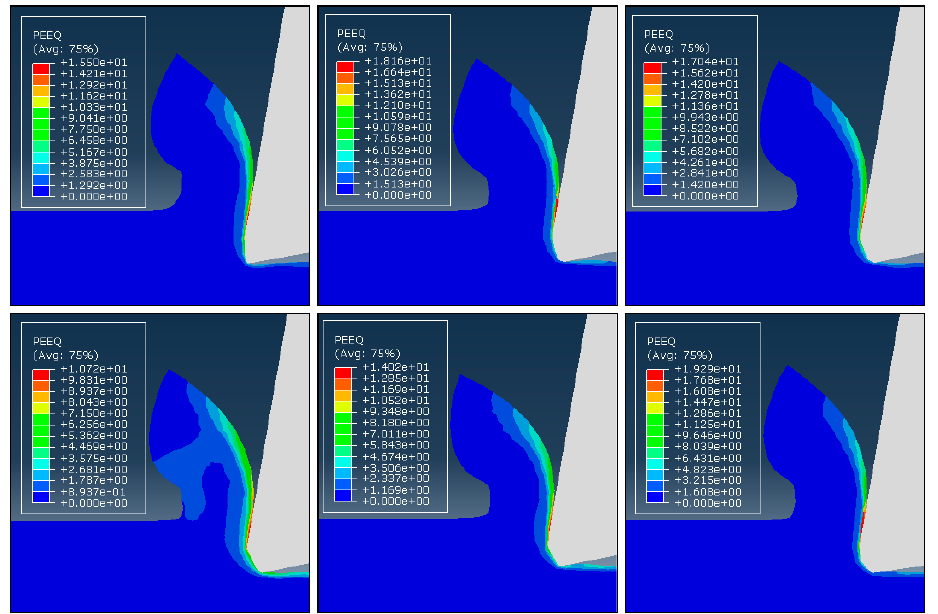
Figure 5. The distribution of strain with different chamfer angles. From top and left: − 10°, − 15°, − 20°, − 25°, − 30°, and − 35°.